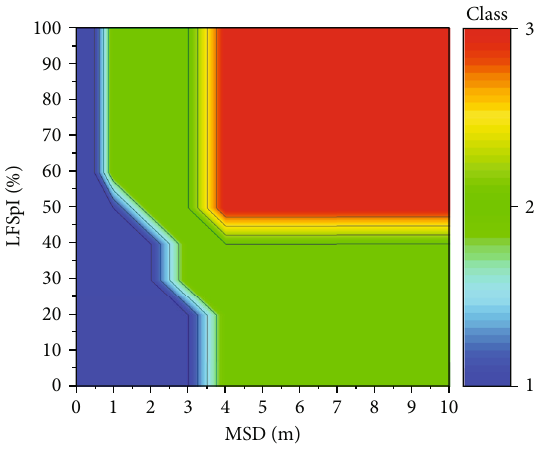
Figure 13: Chart of CWSC